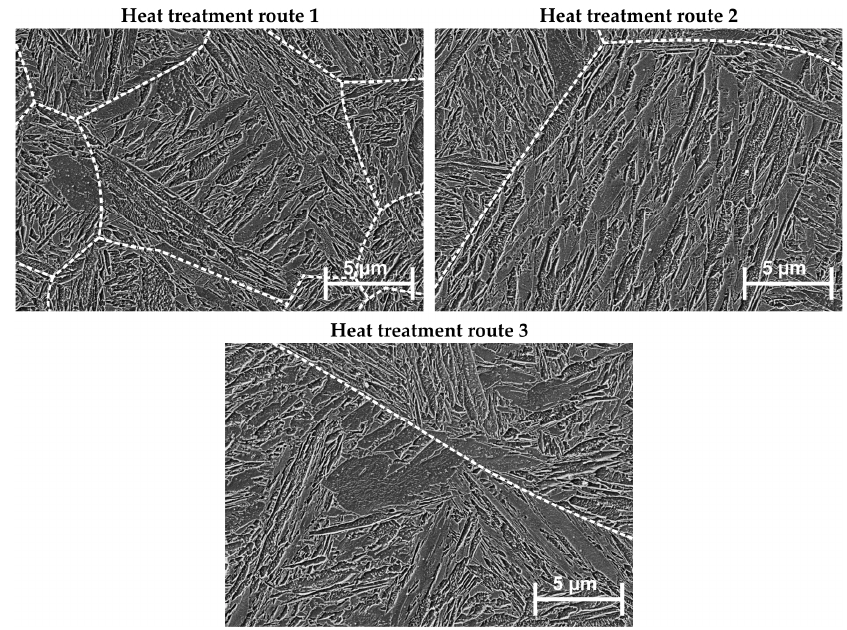
Figure 12. Final microstructure / martensitic morphology after the corresponding heat treatments: prior austenite grain boundaries are highlighted as dashed